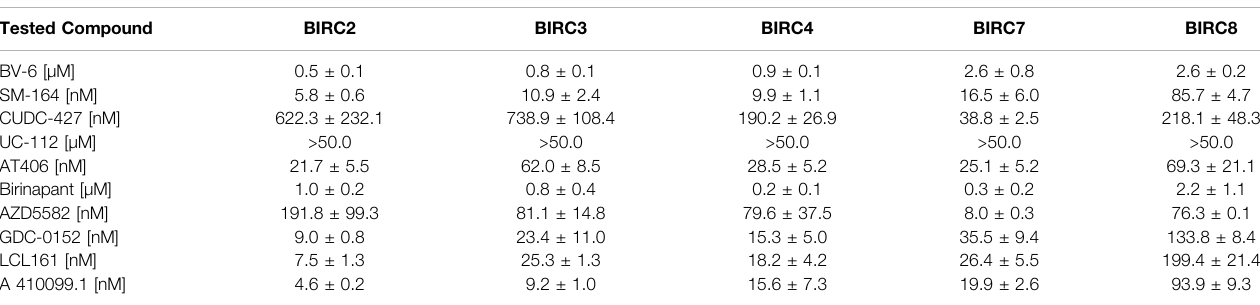
TABLE 2 | Compound EC 50 s ± SEM in the cellular target engagement NanoBRET assay. Tested